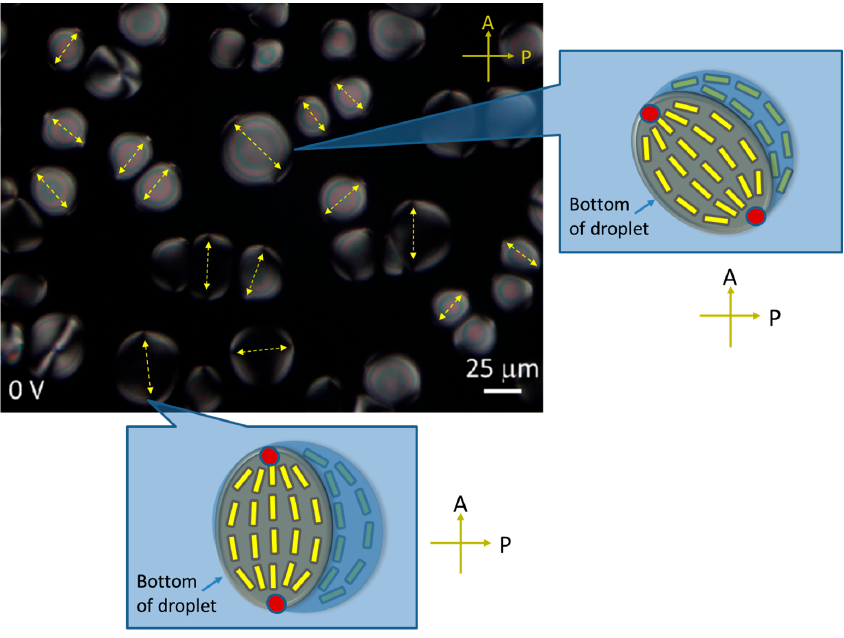
Figure 5. Two examples of LC configuration for dome-like bipolar droplets at V = 0. Yellow arrows and red points represent bipolar axes and two surface point defects in the droplets, respectively. “P” and “A” represent the polarizer and analyzer in POM, respectively. Droplet image is obtained by magnifying Figure 3a.